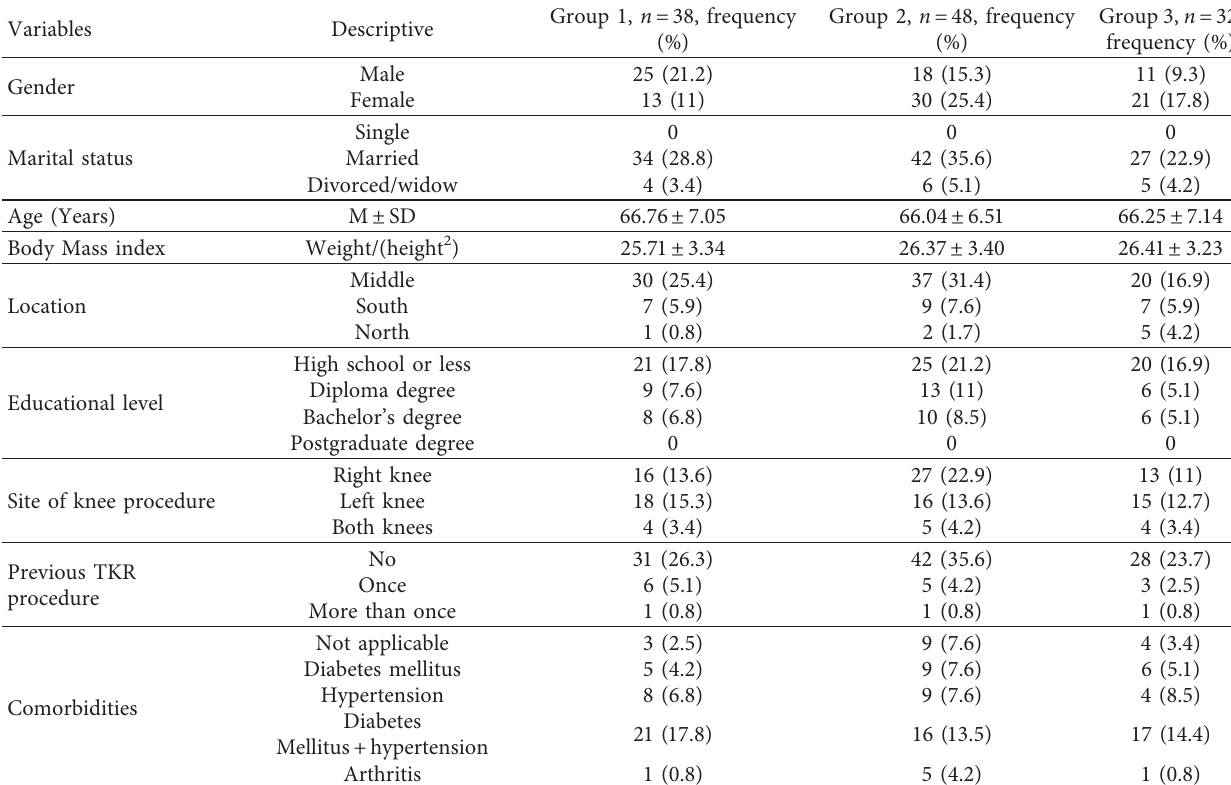
Table 4: Participants’ demographics based on groups.